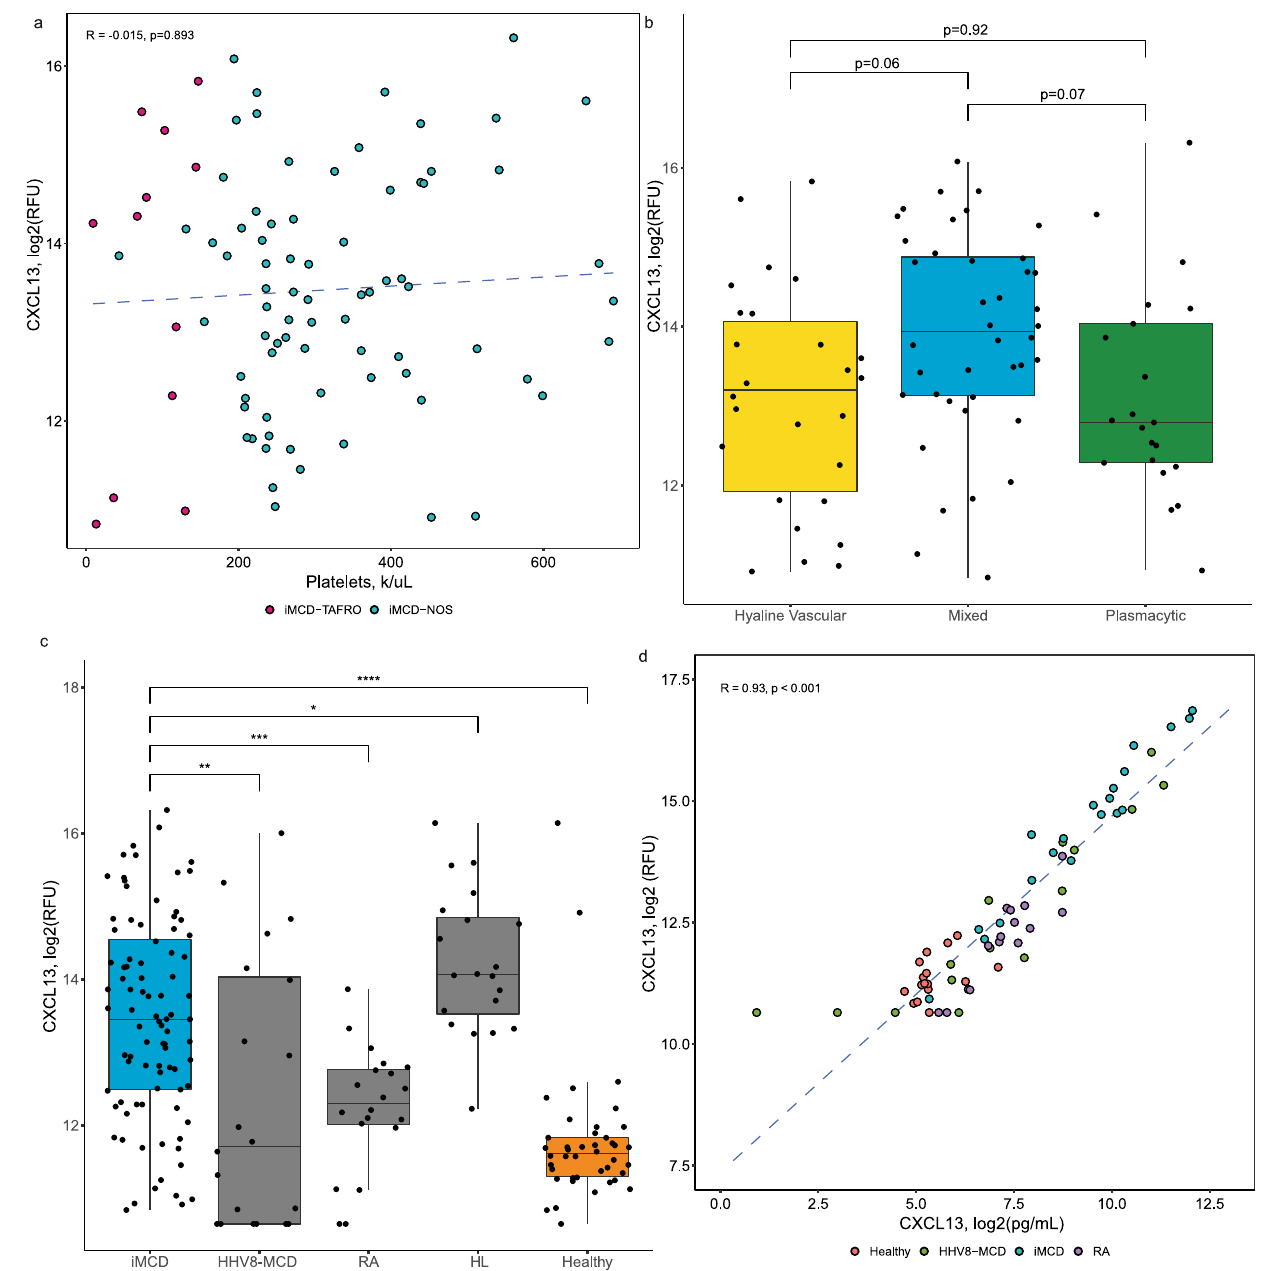
Fig. 2 | Serum CXCL13 differentially expressed in iMCD compared to clin- icopathologicallyoverlappingdiseases.a Spearmanrankcorrelationtestoflog2 CXCL13againstplateletsiniMCD( n =88)atthetimeofsampledraw.Therewasno malizedrelative fl